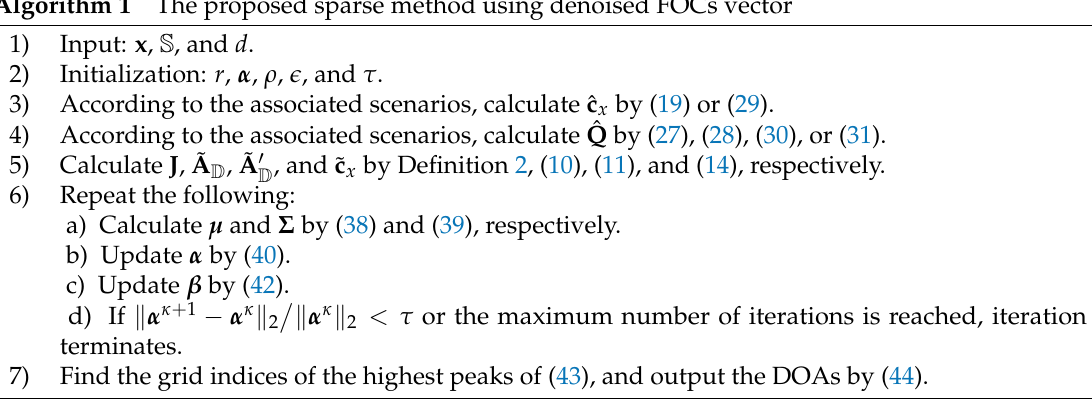
Algorithm 1 The proposed sparse method using denoised FOCs